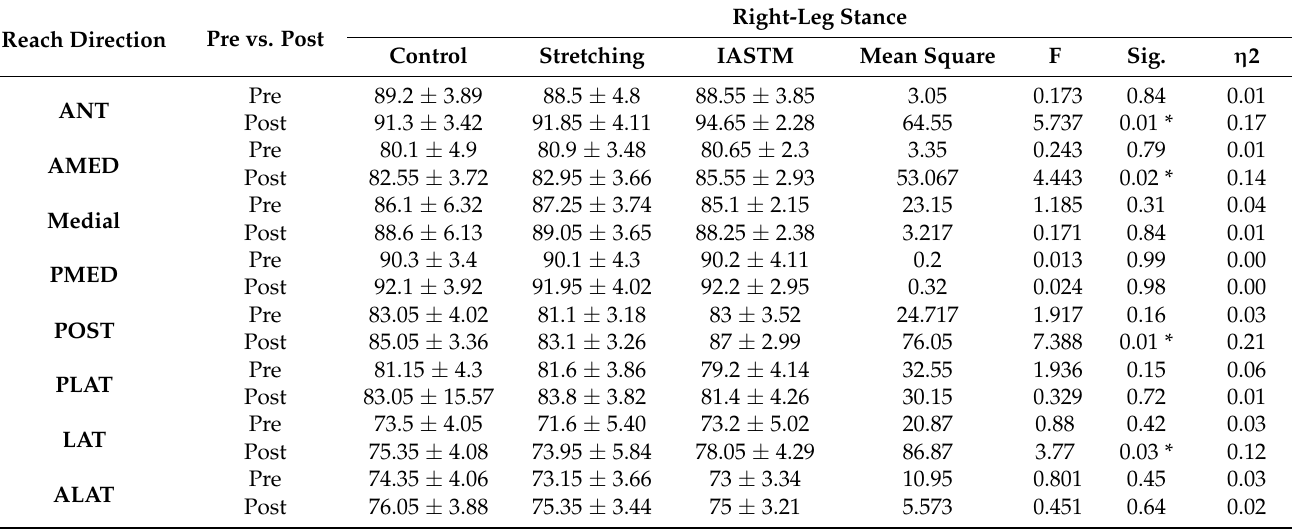
Table 2. Right-leg stance reach distance for star excursion balance test (SEBT) for measuring dy- namic balance.